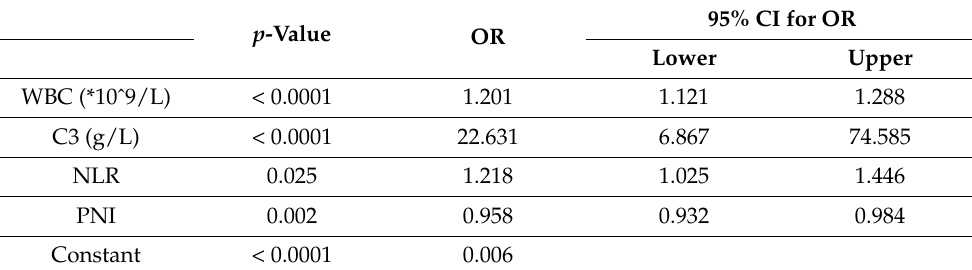
Table 3. Multivariate logistic regression